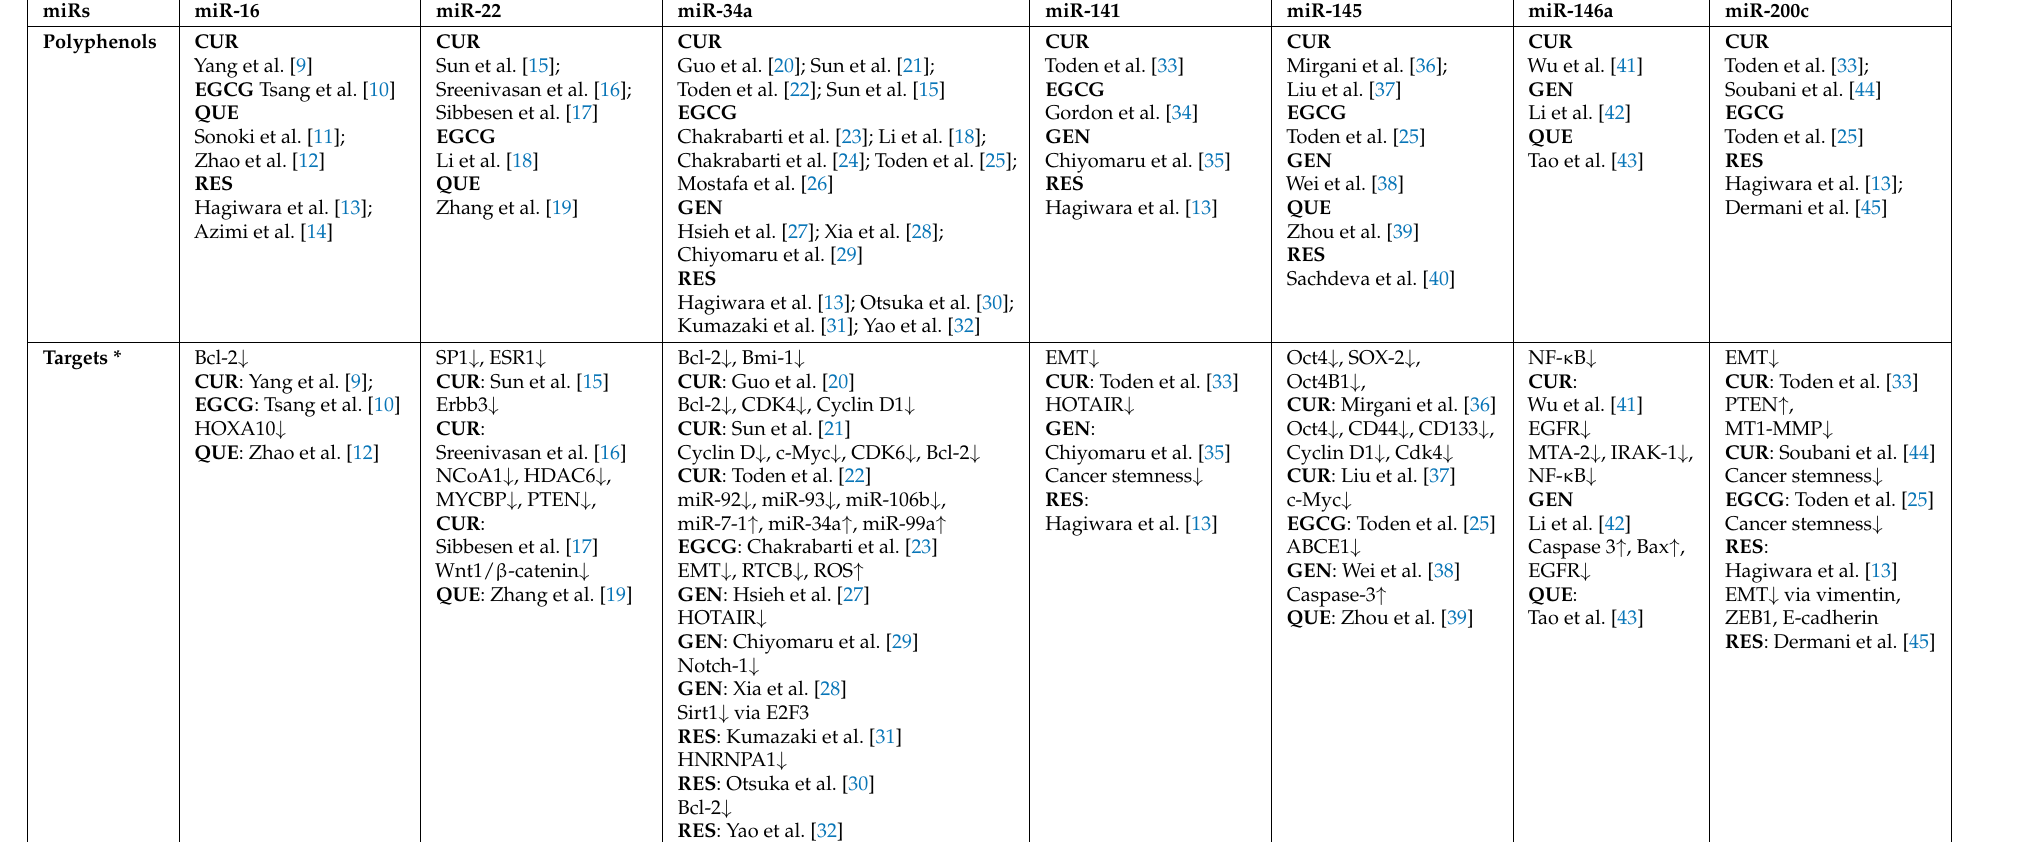
Table 1. Modulation of molecular targets of tumor-suppressor miRs upregulated by three to five CUR, EGCG, QUE, RES and GEN. miRs miR-16 Polyphenols